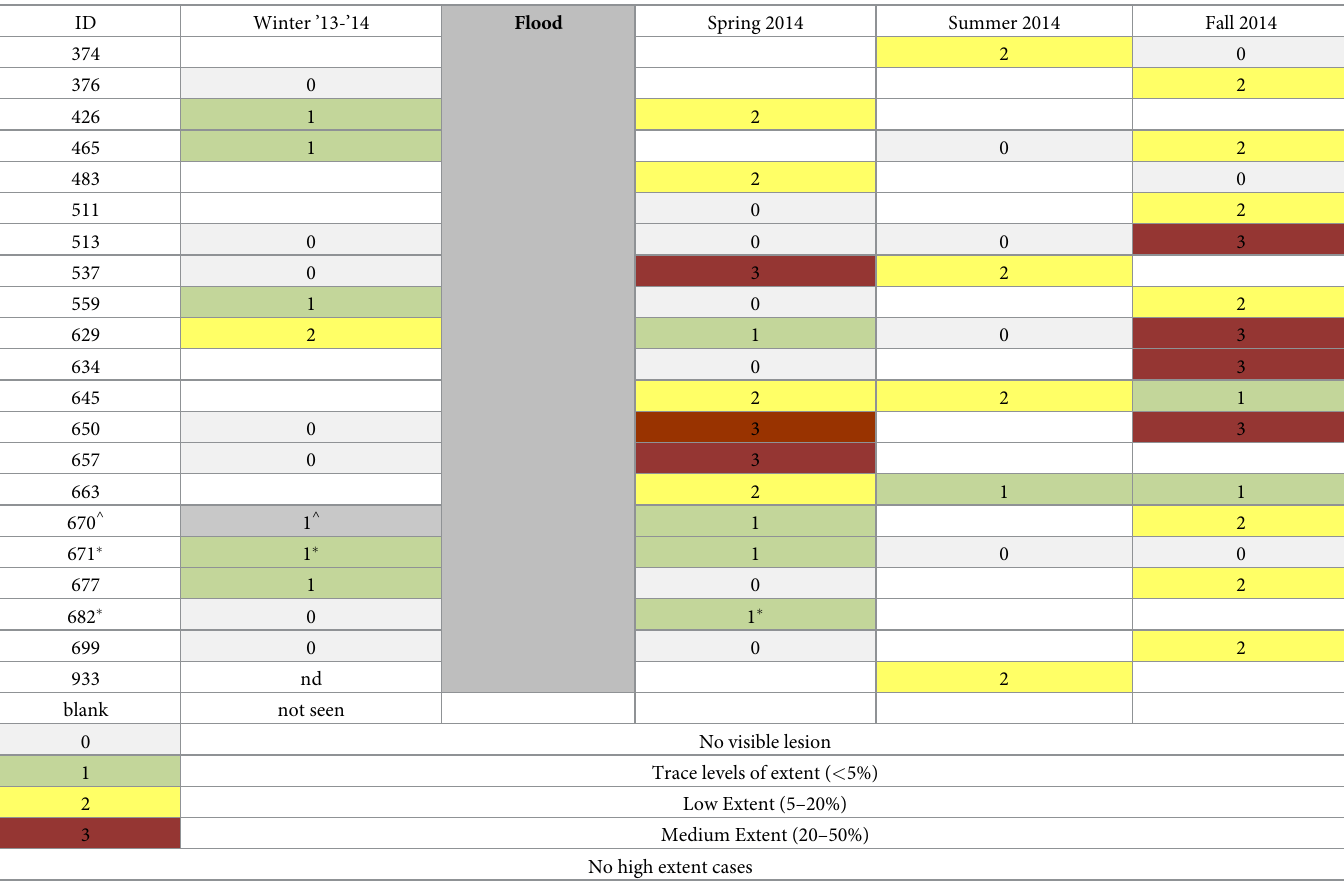
Note : ^Photos available during the winter 2013–2014 season for ID 670 were not good enough quality for inclusion in analyses, however, certainty of skin lesion presence was high and therefore included in this descriptive presentation � Dorsal extent was traced as > 5% but the rating results were < 5% and the dorsal fin + body trace was < 5% for ID 671 and unavailable to trace for ID 682; nd: seen and photos taken but not of good enough quality to determine skin lesion